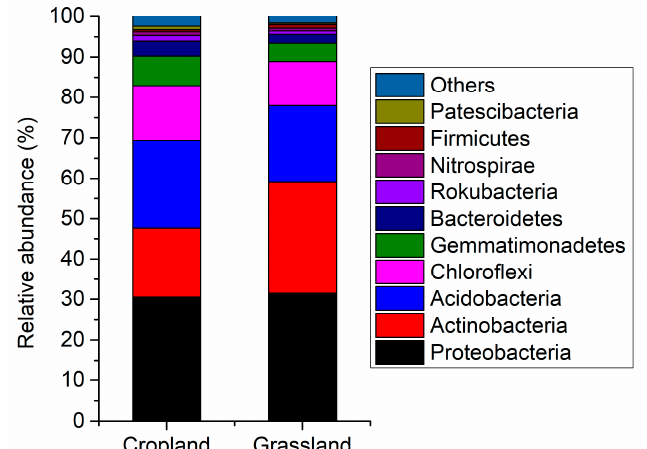
Figure 2. Relative abundance of main bacterial composition in the cropland and grassland soils at the phylum level.